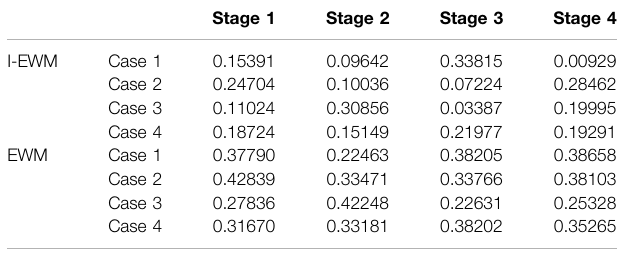
TABLE 1 | Comprehensive evaluation results by I-EWM and EWM.